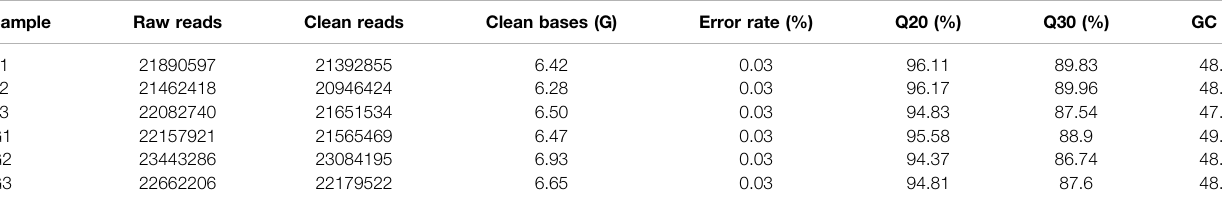
TABLE 4 | Quality control information for transcriptome samples. Sample